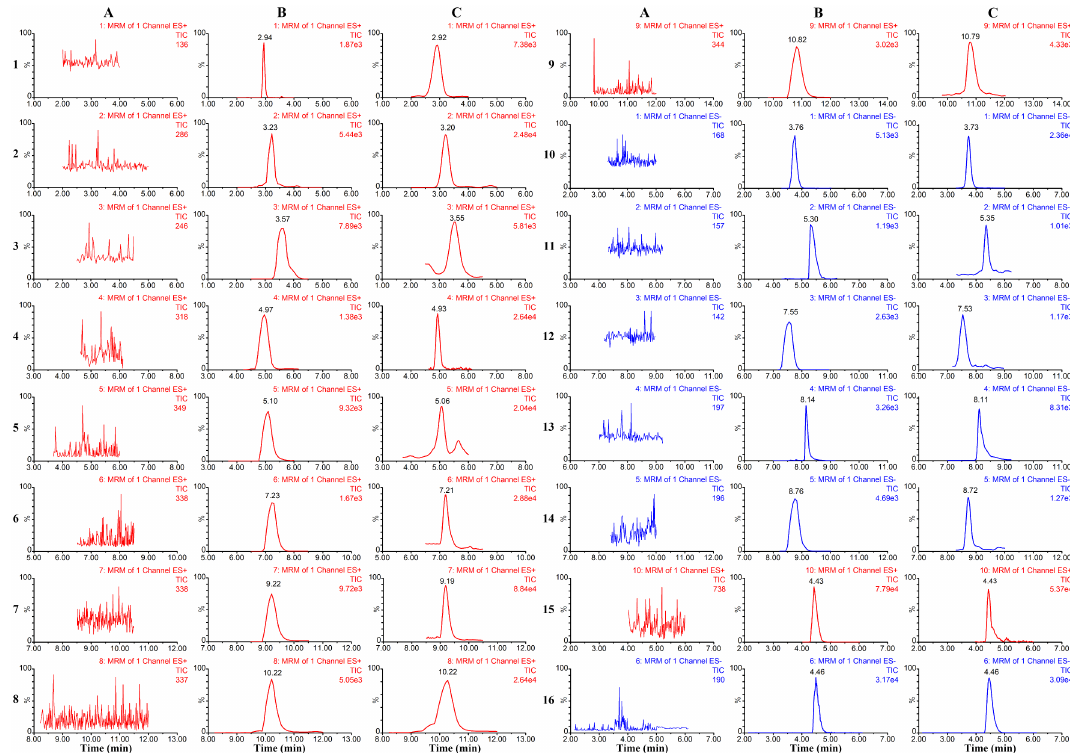
Figure 1. Representative MRM chromatograms of compounds 1–14 and naringenin (IS) in positive ion mode (red) and negative ion mode (blue). ( A ): blank plasma; ( B ): blank plasma spiked with the fifteen analytes and IS; ( C ): plasma sample1h after oral administration of XYP (4 g/kg) (mean ± SD, n = 6). (1) albiflorin, (2) paeoniflorin, (3) quercetin, (4) ferulic acid, (5) senkyunolide I, (6) isoliquiritigenin, (7) atractylenolide III, (8) ligustilide, (9) atractylenolide II, (10) liquiritin,